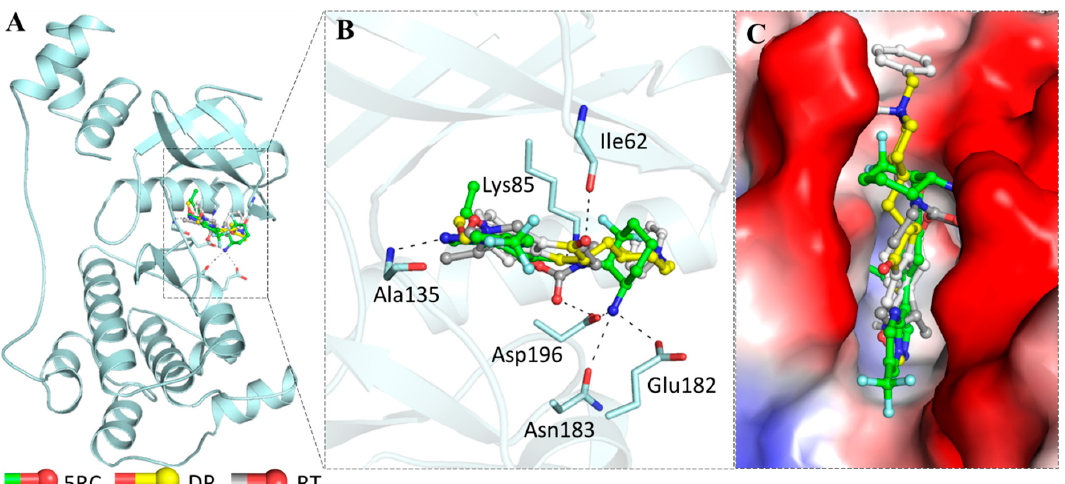
Figure 7. Interactions of DP and RT with MARK4. ( A ) Cartoon representation showing the docked DP, RT, and standard inhibitor 5RC, interacting with the binding site of MARK4. ( B ) Zoomed view of the binding pocket and its interaction with DP, RT, and standard MARK4 inhibitor. ( C ) Potential surface view of MARK4 binding pocket occupied by DP, RT, and standard MARK4 inhibitor.